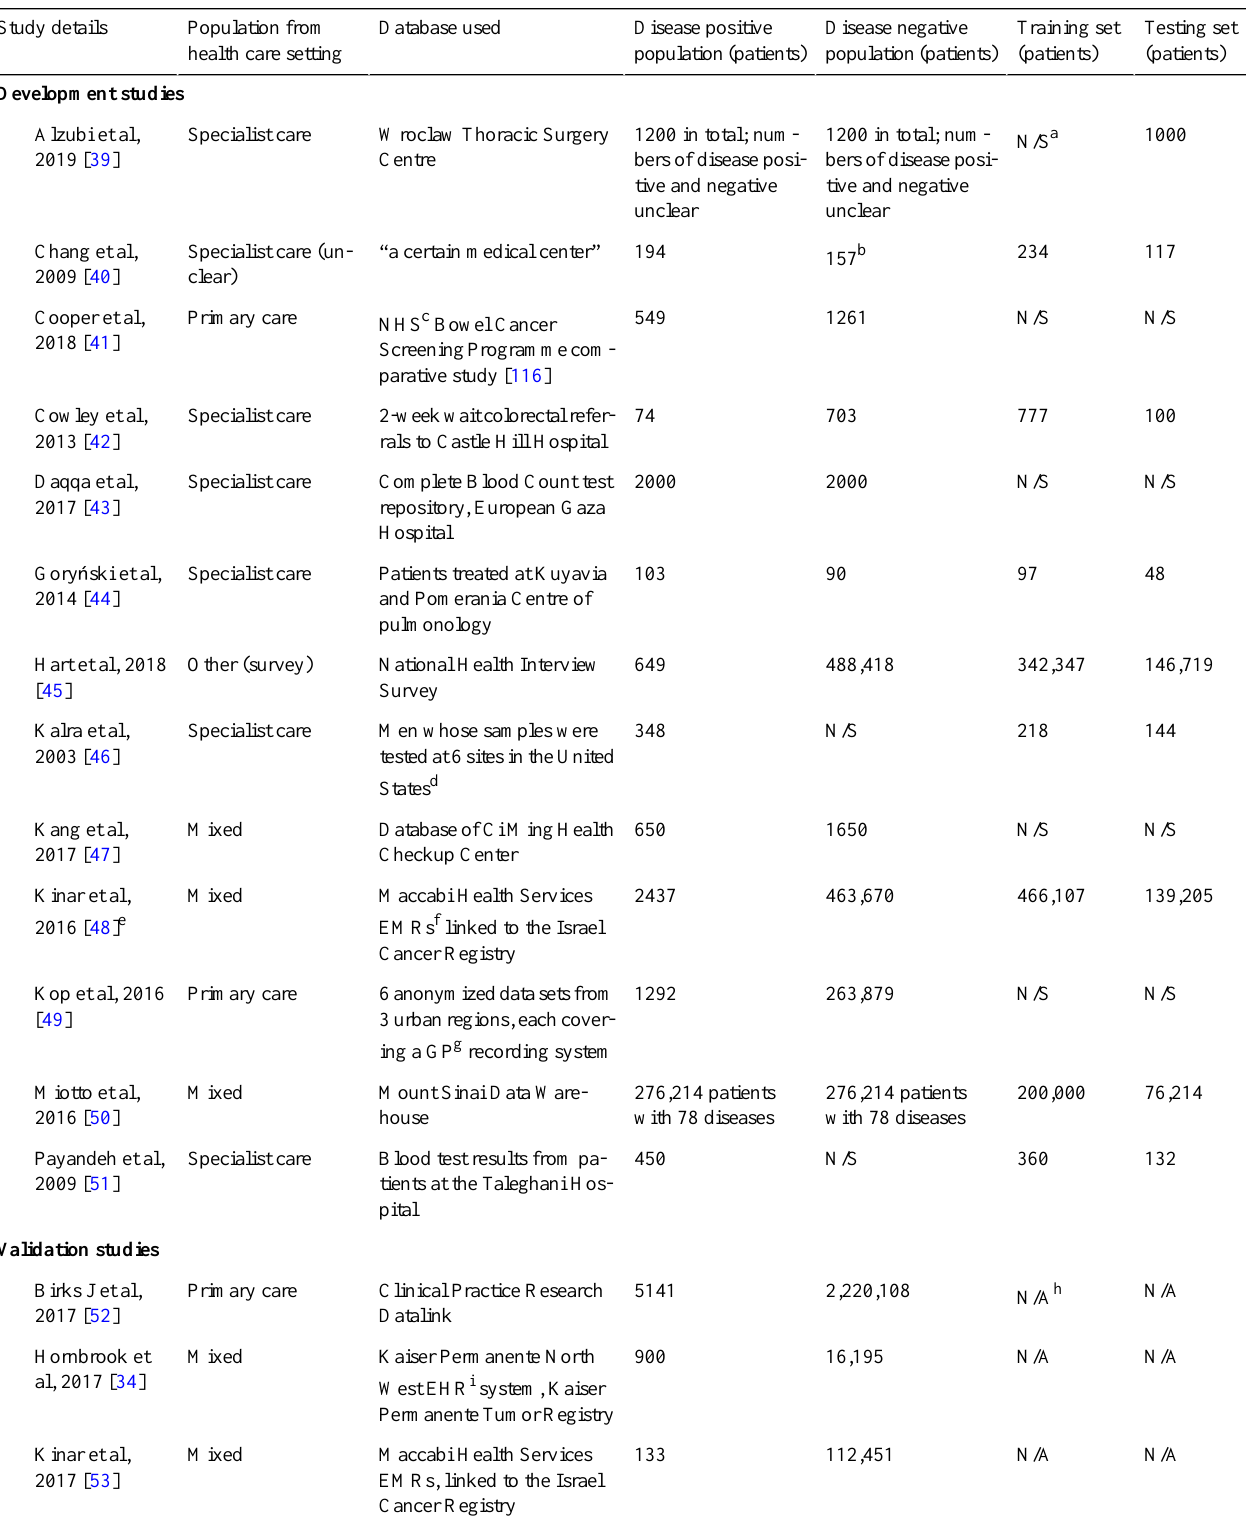
Table 3. Study population and study design.